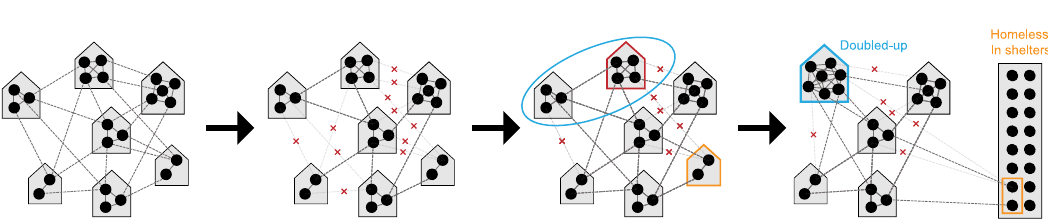
Fig. 1 Modeling the effect of evictions on SARS-CoV-2 transmission. We model the spread of infection over a transmission network where contacts are divided into those occurring within a household (solid gray lines) vs. outside the house ( “ external contacts ” , dotted gray lines). Social distancing interventions (such as venue and school closures, work-from-home policies, mask-wearing, lockdowns, etc) are modeled as reductions in external contacts (red x ’ s), while relaxations of these interventions result in increases in external contacts towards their baseline levels. When a household experiences eviction (red outline), we assume the residents of that house “ double-up ” by merging with another house (blue circle), thus increasing their household contacts. Evictions can also directly lead to homelessness (orange outline), and residence in shelters or encampments with high numbers of